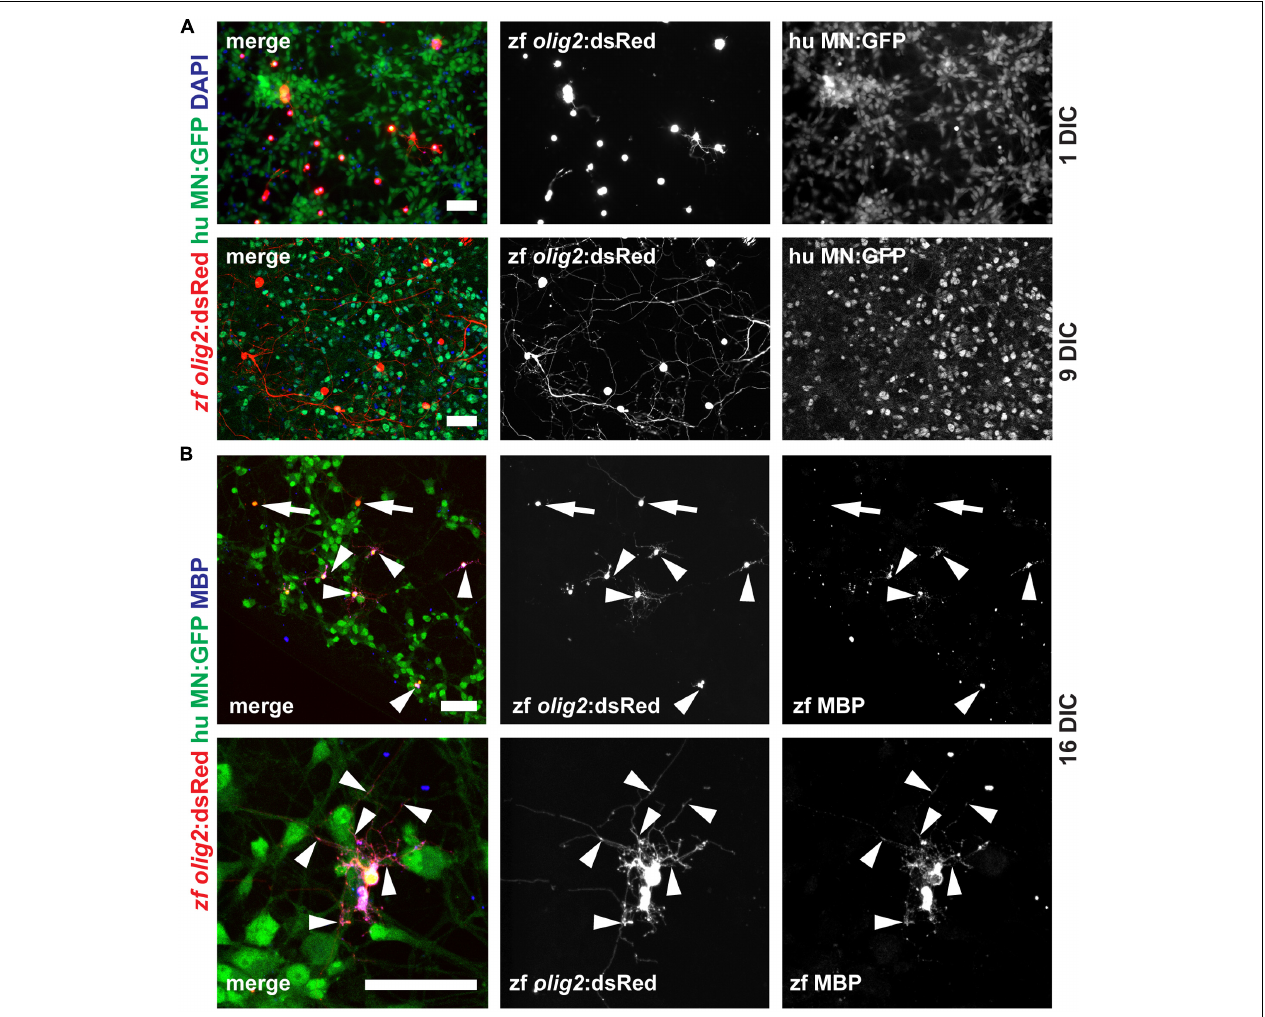
FIGURE 7 | Adult zebrafish OPCs differentiate into MBP-positive mature OLs in human MN co-cultures. (A) OPCs differentiate over time in co-culture as identified by increased branching of the seeded OPCs. (B) At 16 DIC, the majority of oligodendroglial cells expresses the mature OL/myelin sheath marker protein MBP (arrowheads) while only a few cells fail to differentiate and remain MBP-negative (arrows); scale bars represent 50 µ